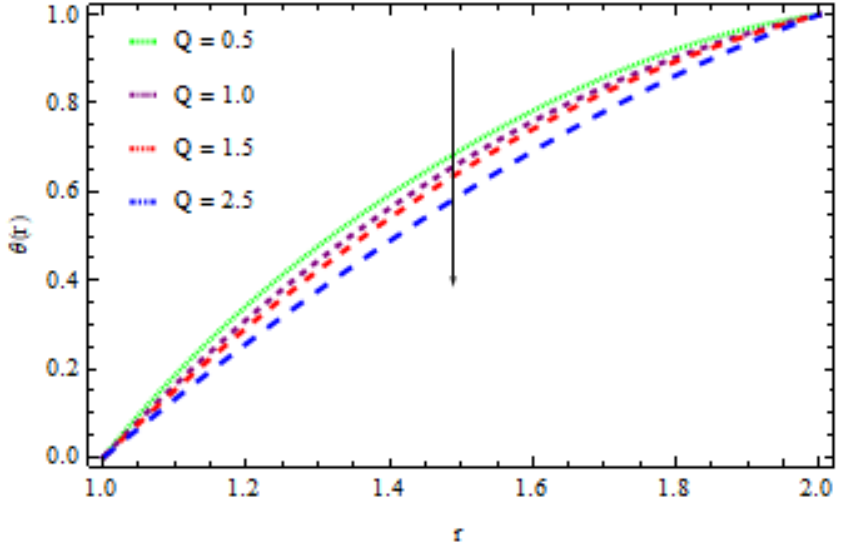
Figure 12. The influence of M on temperature distribution for Reynolds’ model (RM) when β 0 = 1, m = 0.1, Q = 0.1, B r = 0.1, ε = 0.5, N = 0.1, K p = 0.1.